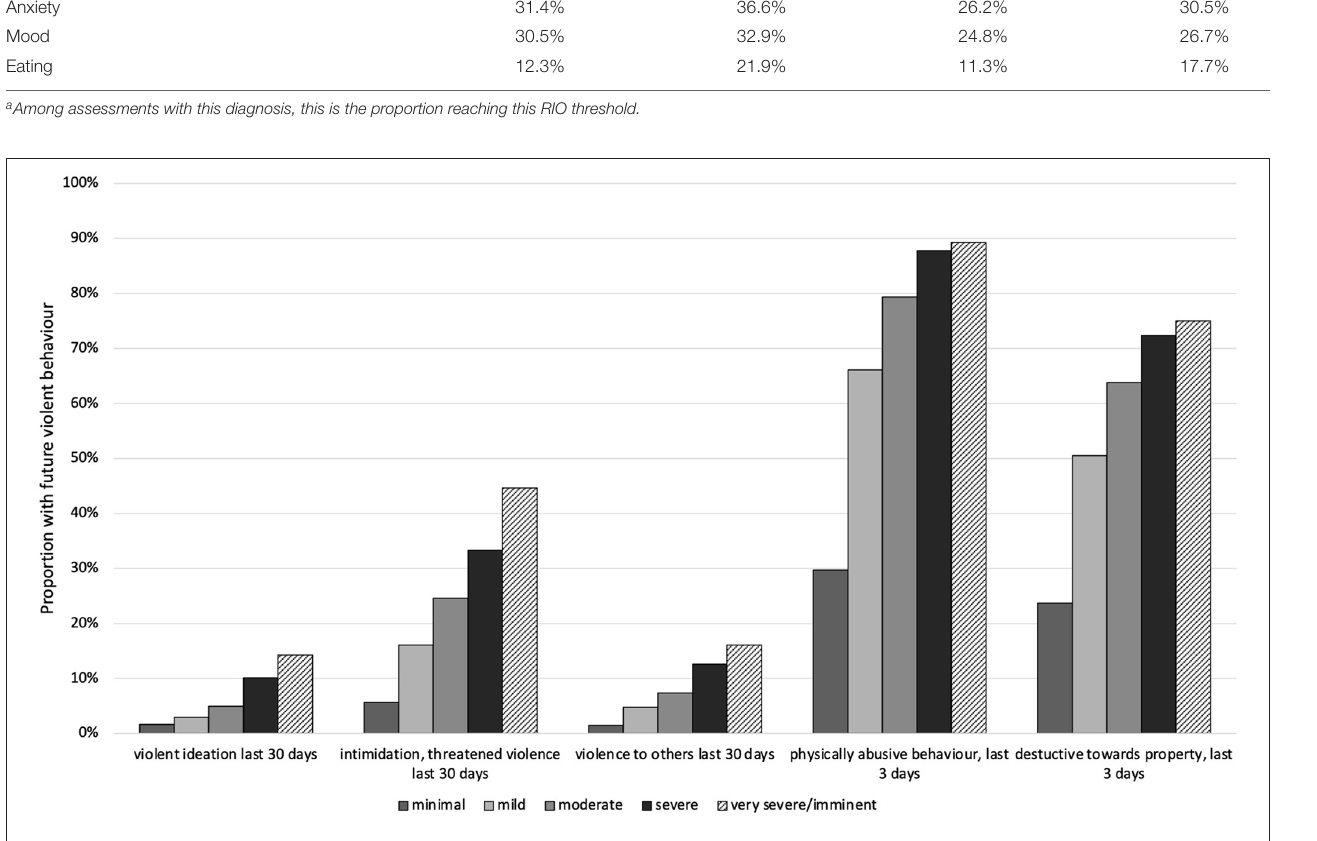
Use and Utility of